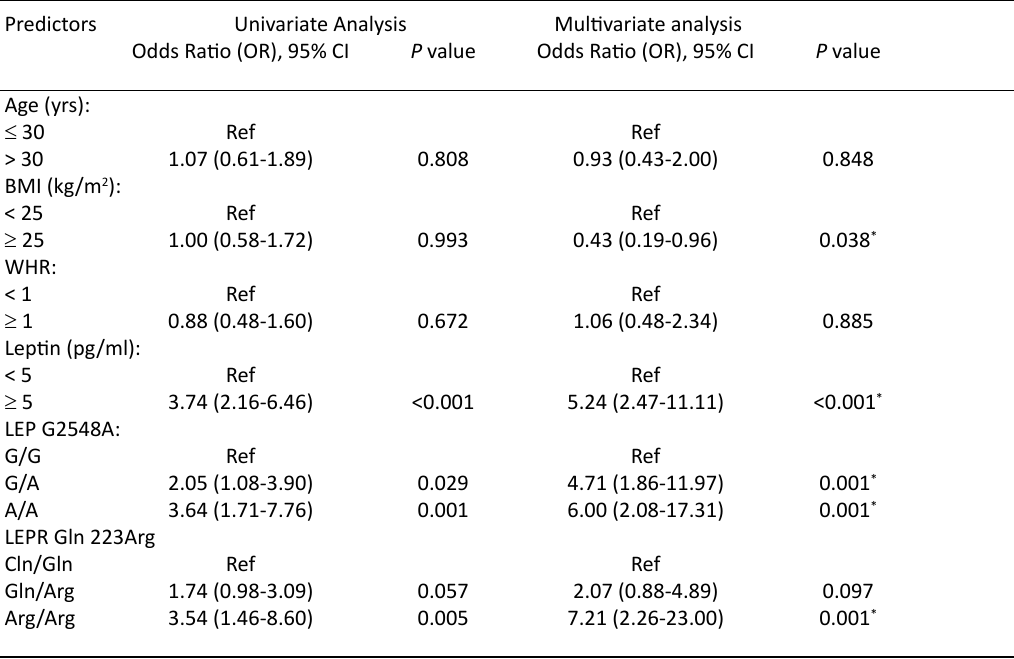
Table 6. Identification of predictors of unexplained infertility among clinical characteristics and gene polymorphisms using logistic regression analysis Predictors Univariate Analysis Multivariate analysis Odds Ratio (OR), 95% CI P value Odds Ratio (OR), 95%